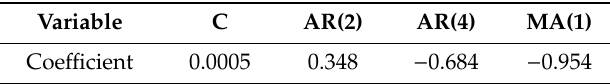
Table 6. Model parameters of ARIMA